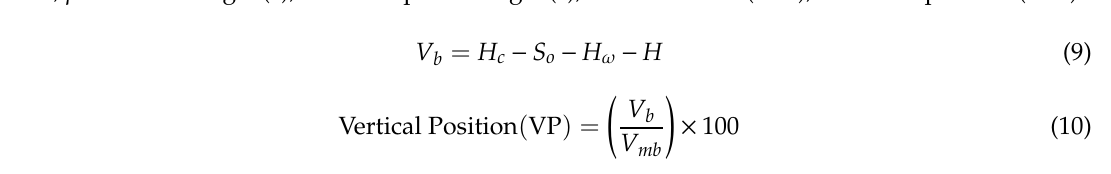
Figure 2. Concepts of the solar azimuth and altitude.